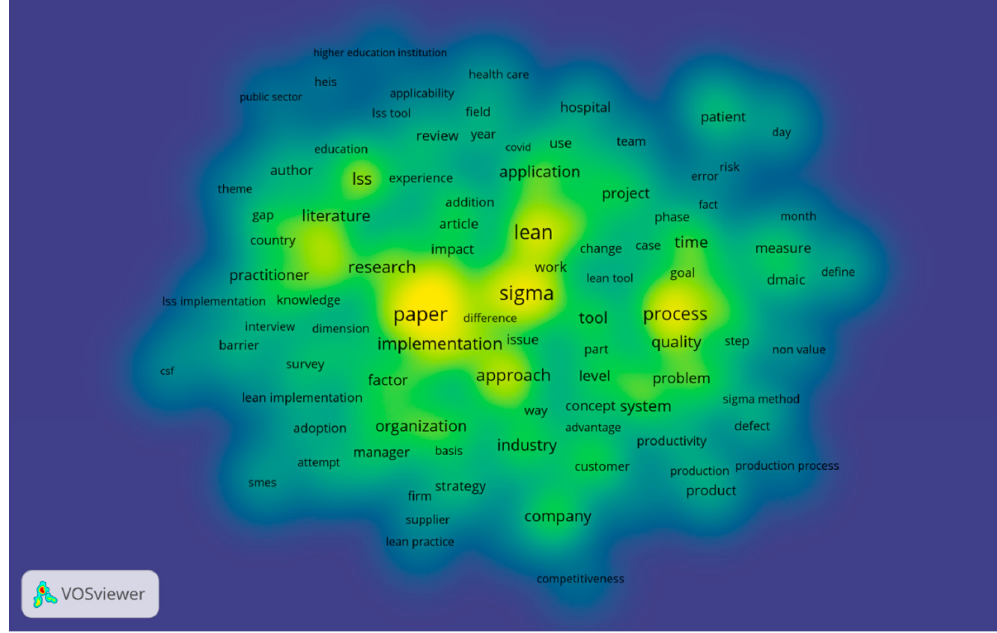
Figure 1. Most common words in scientific publications.